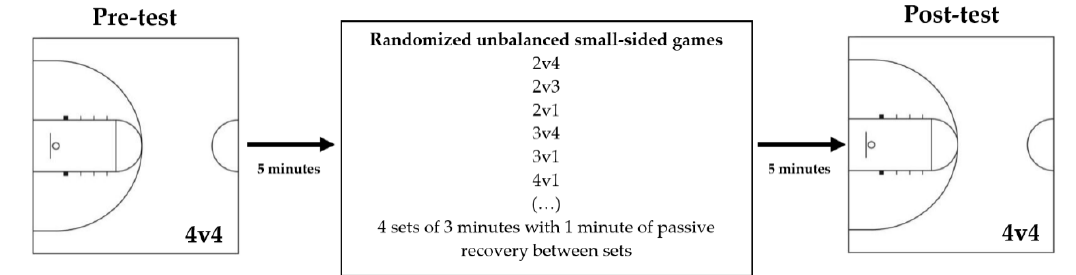
Figure 1. Representation of the daily intervention timeline.